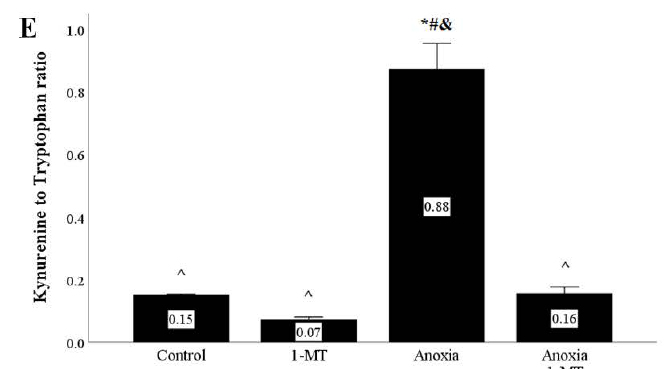
Figure 1. Anoxia upregulates IDO expression and activity. Cells were cultured under anoxic conditions for 24 h along with the indicating treatments. Anoxia in the presence or not of 1MT or CH223191 increased IDO protein level. A representative Western blot experiment is displayed in panel ( A ), whereas panel ( B ) depicts the cumulative results of four repeated experiments. * p < 0.05 vs. Control, # p < 0.05 vs. Control with 1-MT, ^ p < 0.05 vs. Control with CH223191, & p < 0.05 vs. Anoxia, + p < 0.05 vs. Anoxia with 1-MT, ! p < 0.05 vs. Anoxia with CH223191. IDO activity assessed by the ratio of kynurenine to tryptophan concentration in cell culture supernatants also increased under anoxic conditions, an effect that is abolished by the IDO inhibitor 1-MT ( C – E ). Six such experiments were performed. * p < 0.05 vs. Control, # p < 0.05 vs. Control with 1-MT, ^ p < 0.05 vs. Anoxia, & p < 0.05 vs. Anoxia with 1-MT. Error bars correspond to SEM. 1-MT, 1-DL- methyltryptophan; IDO, indoleamine 2,3-dioxygenase 1.